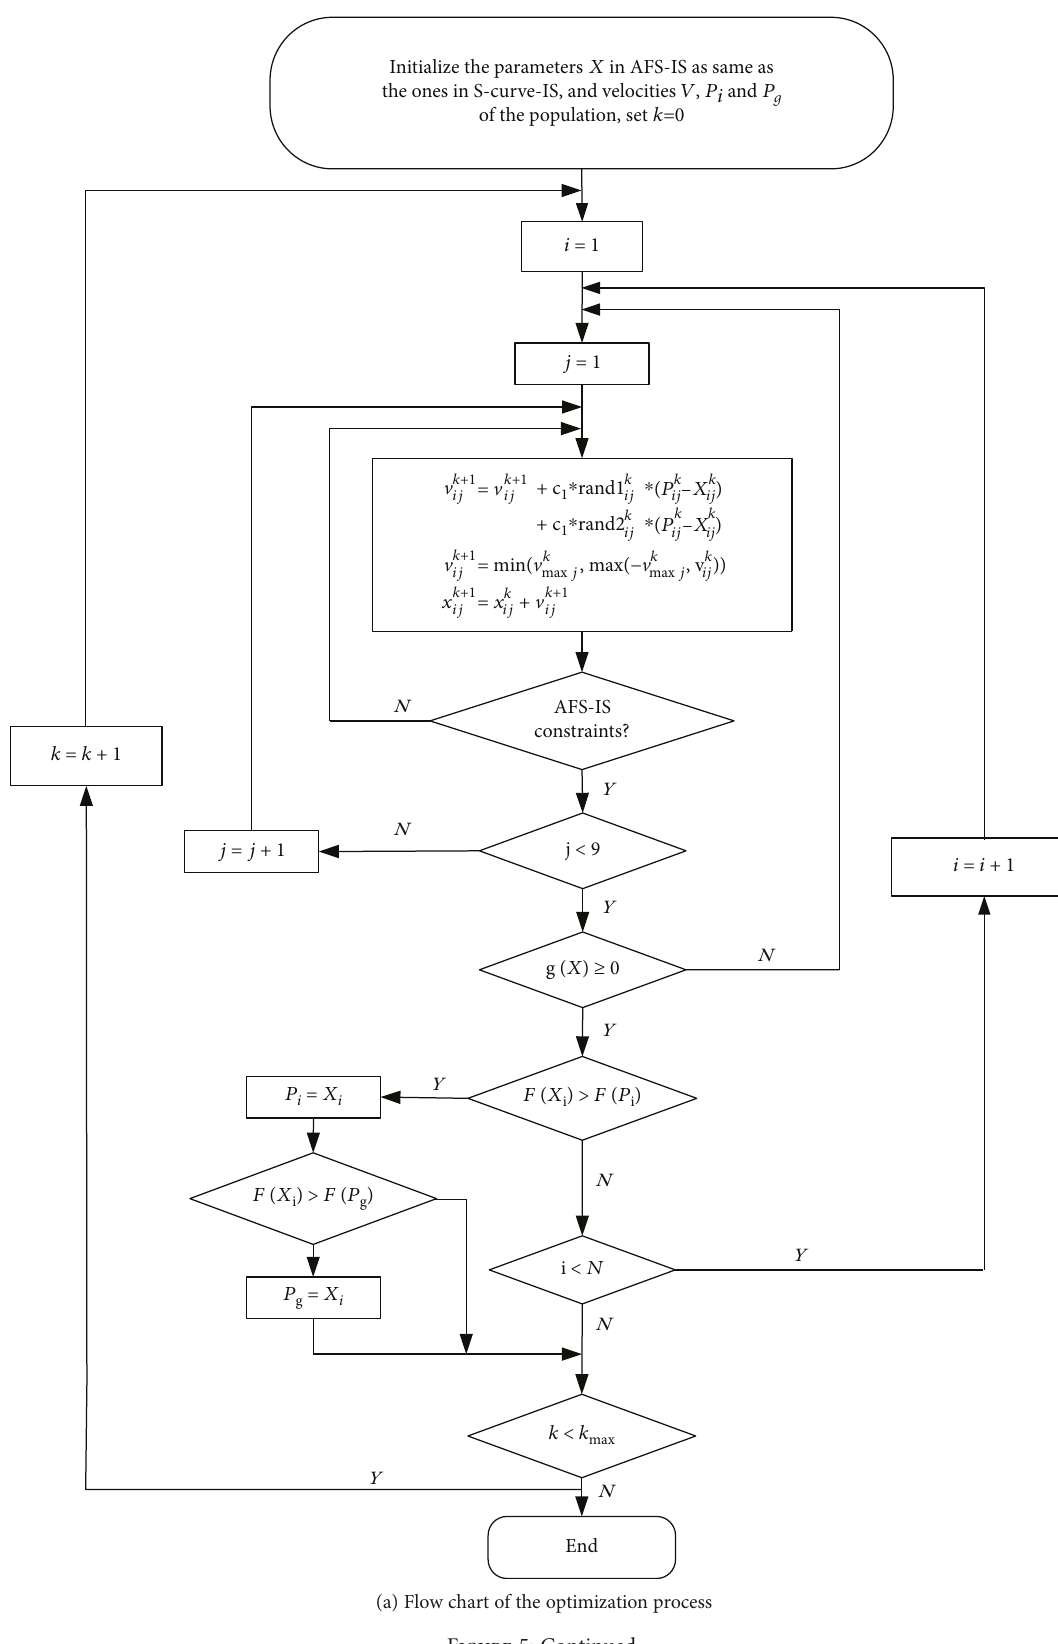
(a) Flow chart of the optimization